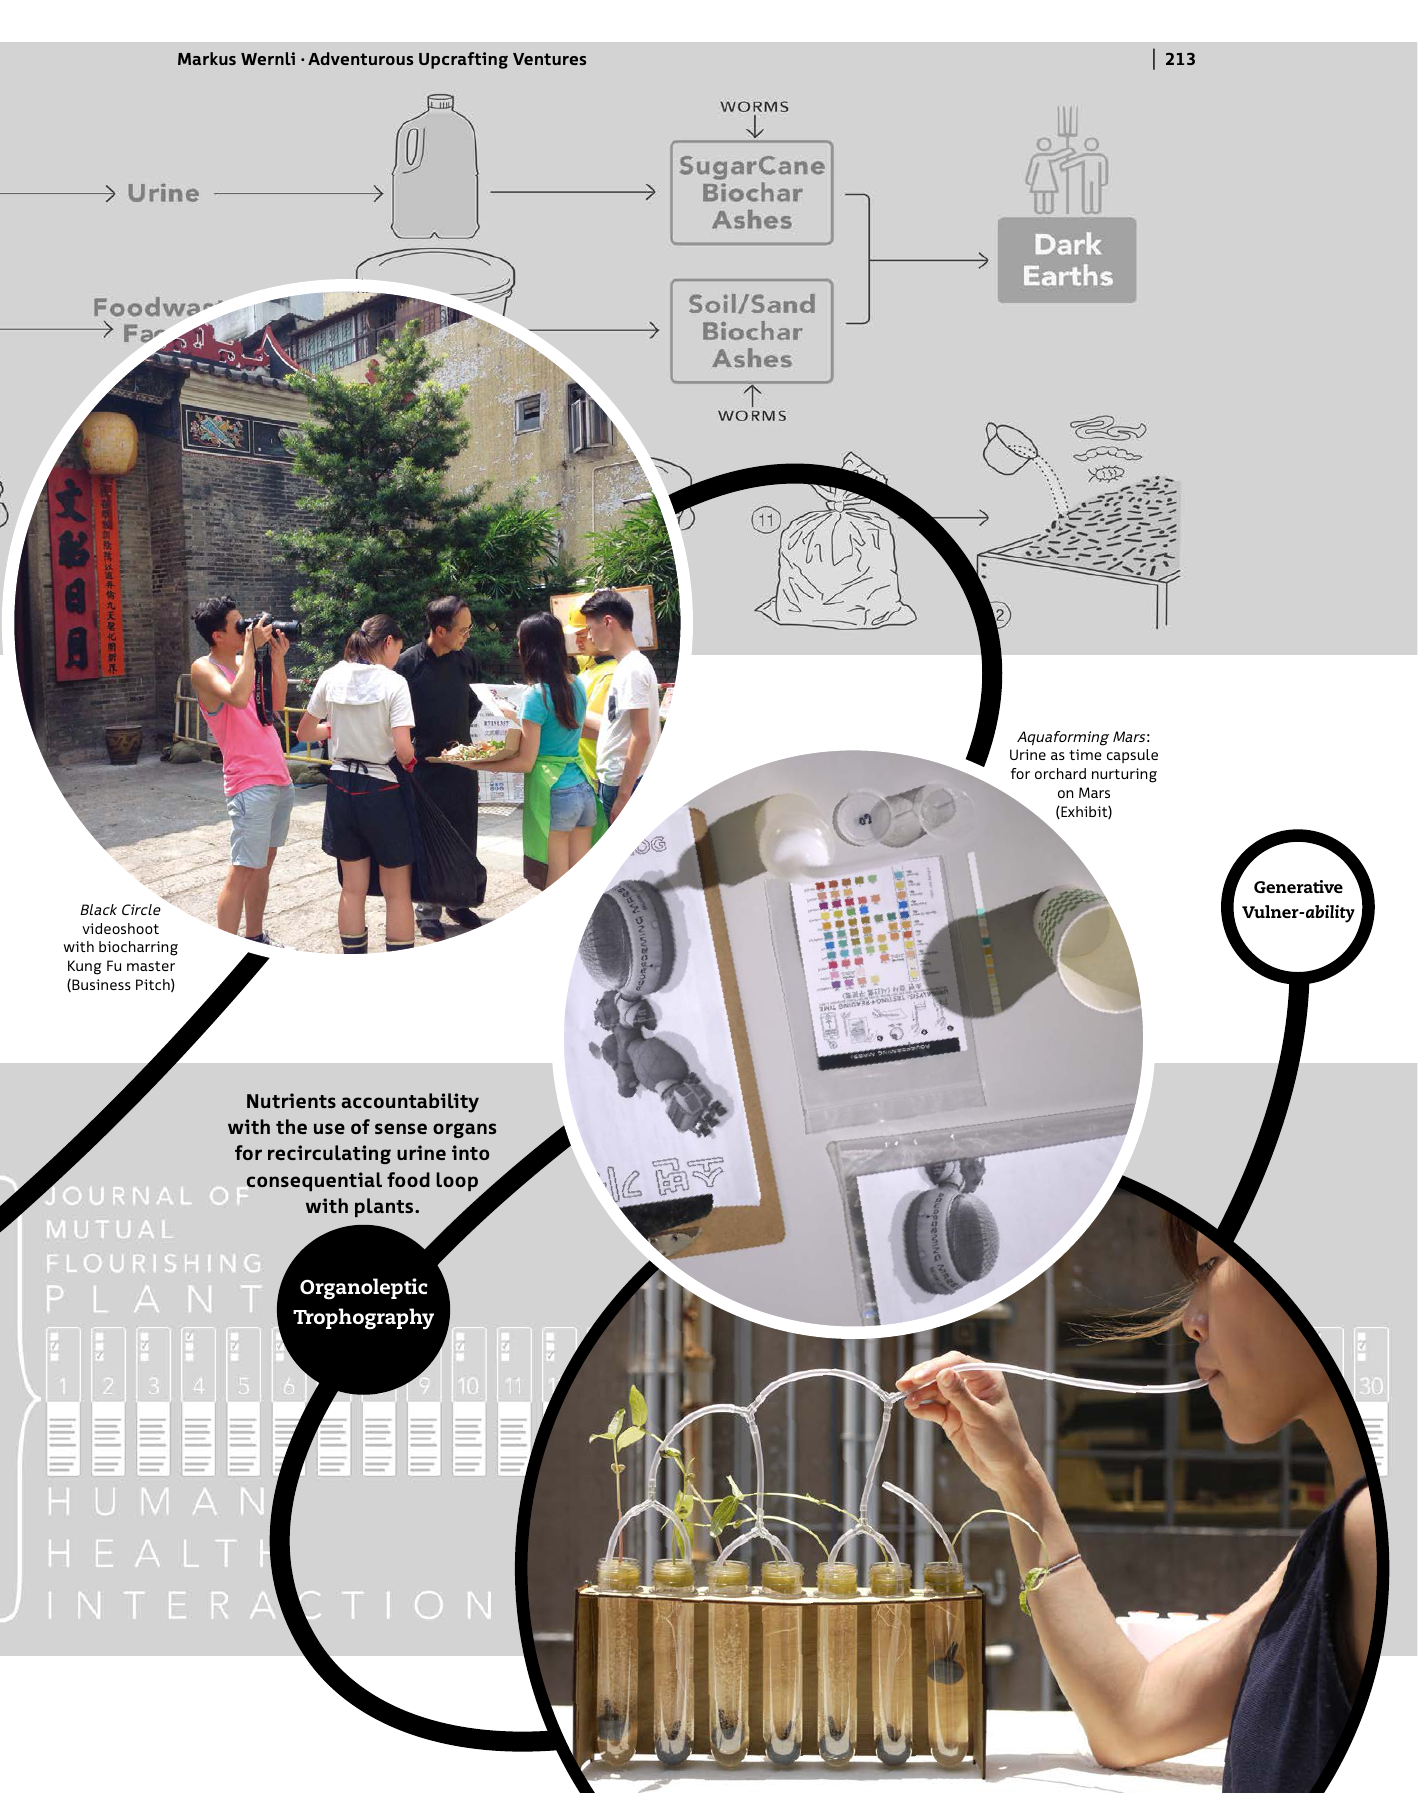
Black Circle videoshoot with biocharring Kung Fu